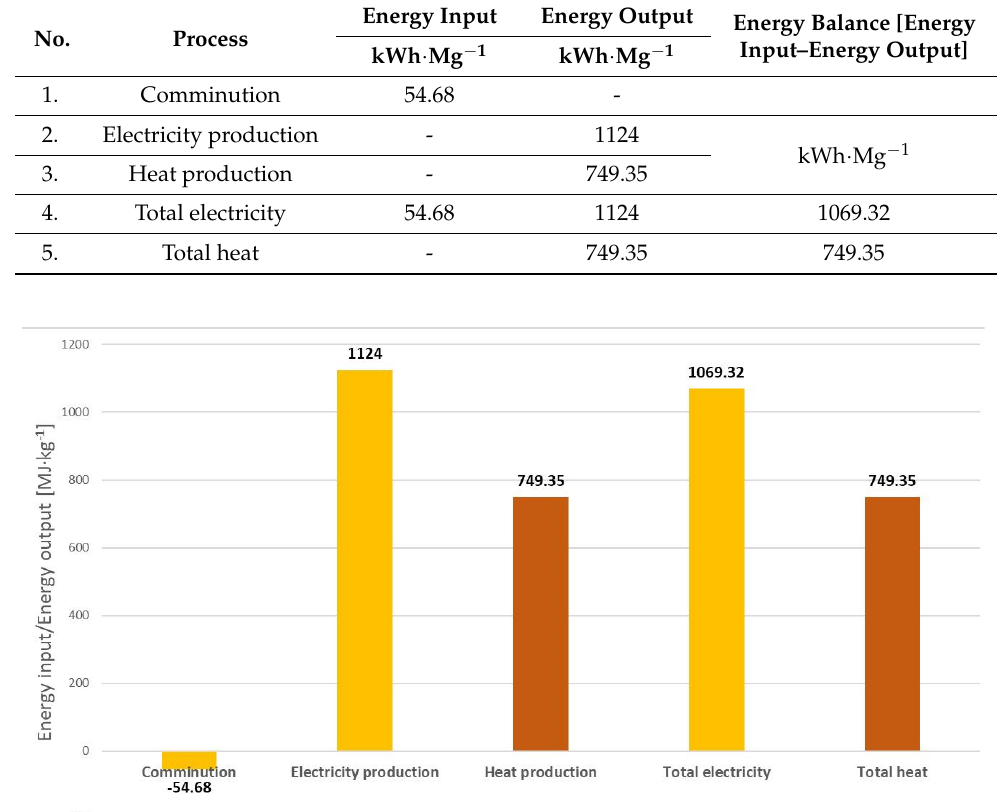
Figure 8. The energy balance of biogas produced from shredded Silphium perfoliatum L.